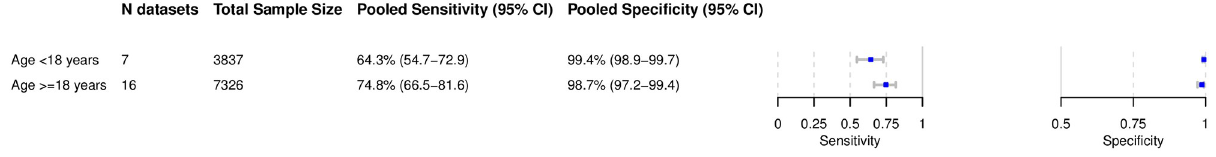
Fig 10. Pooled sensitivity and specificity by age.